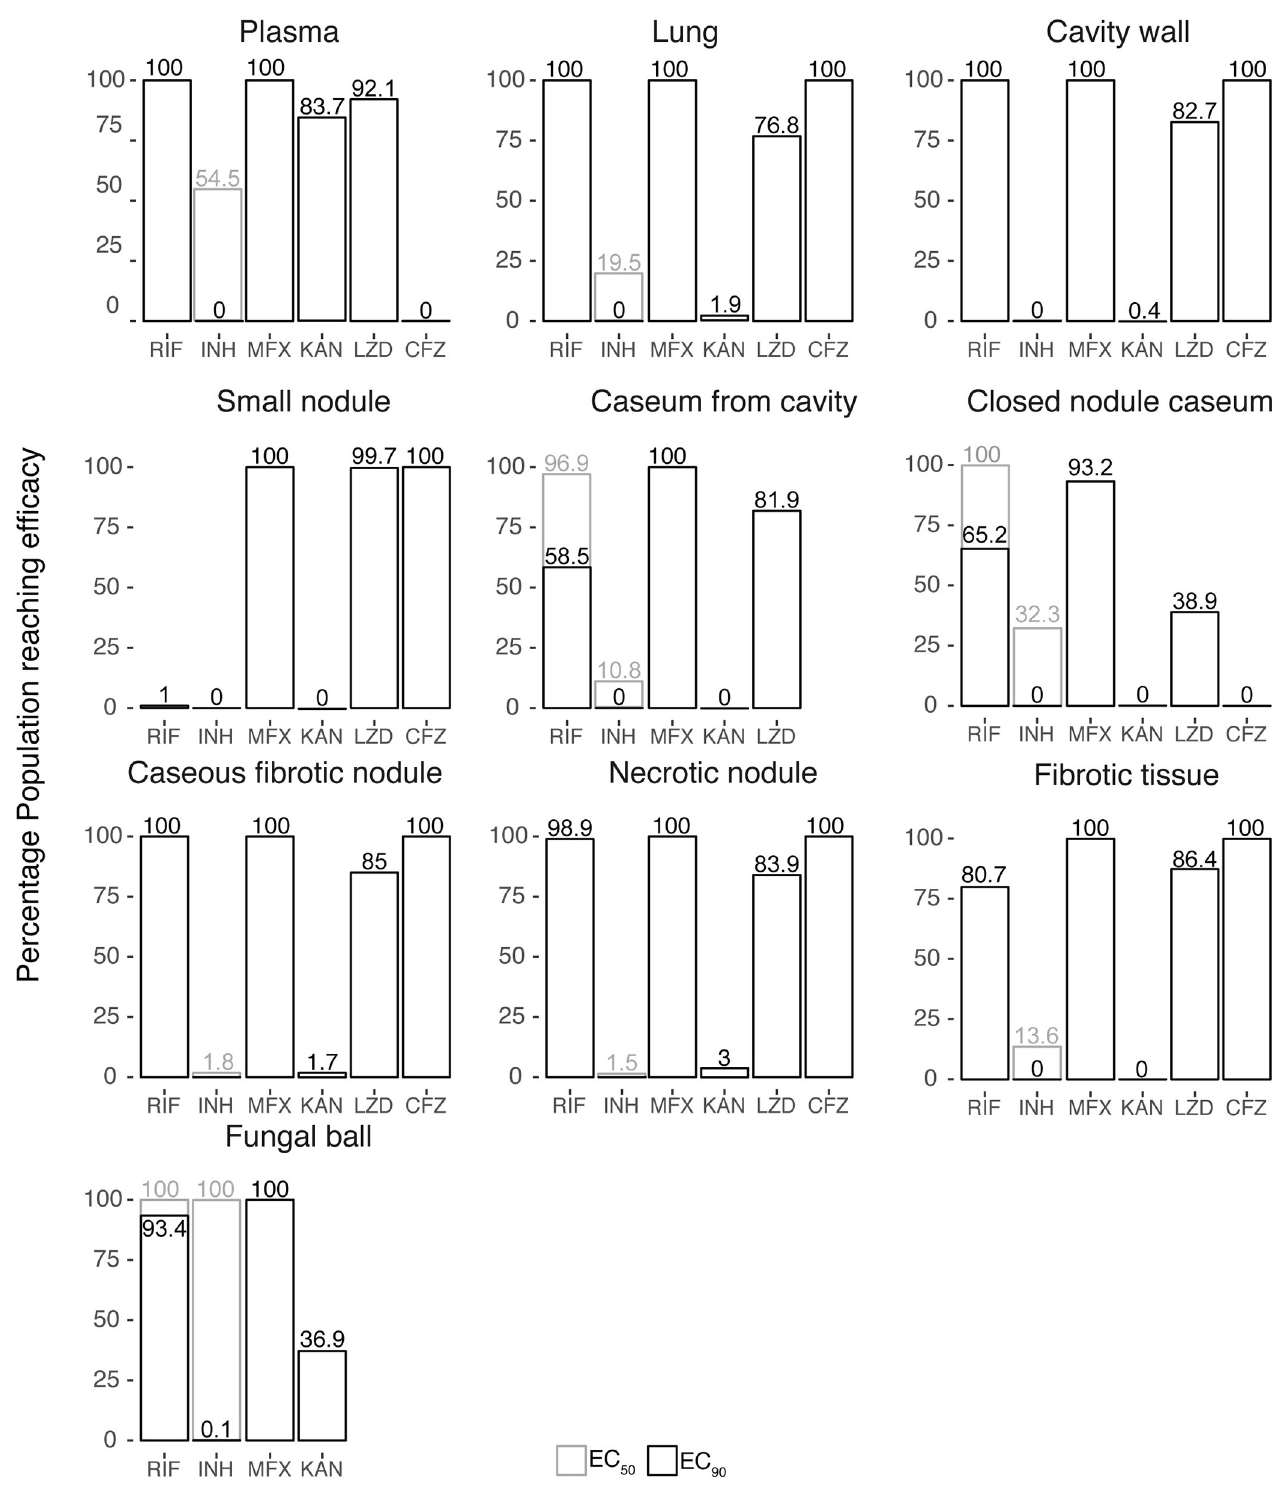
Fig 8. Prediction of drug efficacy by lesion type. Using defined critical PK/PD exposure values, a population of 1,000 simulated patients were defined as reaching efficacy or not from their PK simulations. The percentage of those reaching efficacy are shown as percentage box plots to compare the drugs that are able to reach a higher ratio of efficacy in specific lesions. Black boxes represent the percentage population reaching EC 90, and if available, gray boxes represent the percentage population able to reach EC 50 . EC 90 , 90% maximal effective concentrations; EC 50 , 50% maximal effective concentrations; PK/PD, pharmacokinetic/pharmacodynamics.